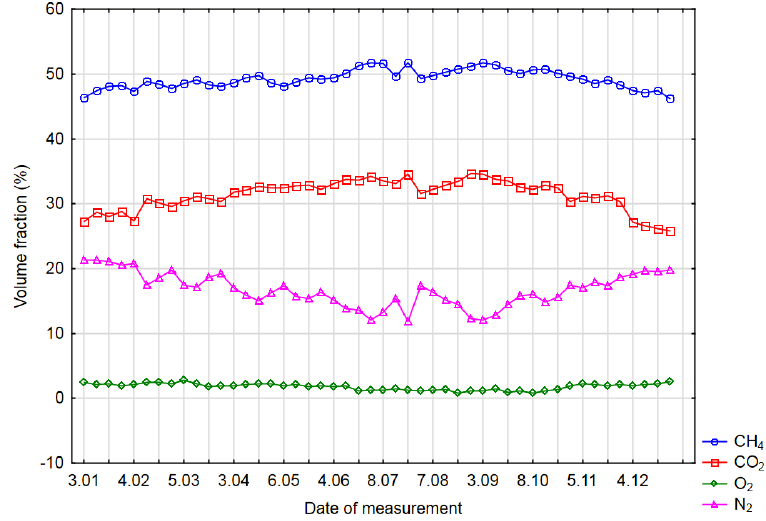
Figure 2. Biogas parameters in the single object (SO1) well.